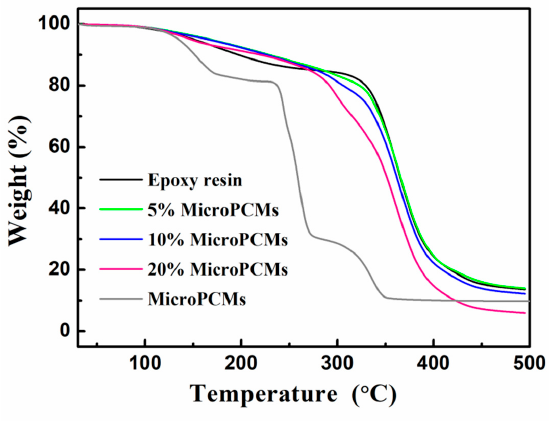
Figure 9. TGA thermograms of MicroPCMs, pure epoxy resin and MicroPCMs/epoxy composites with different MicroPCM contents.